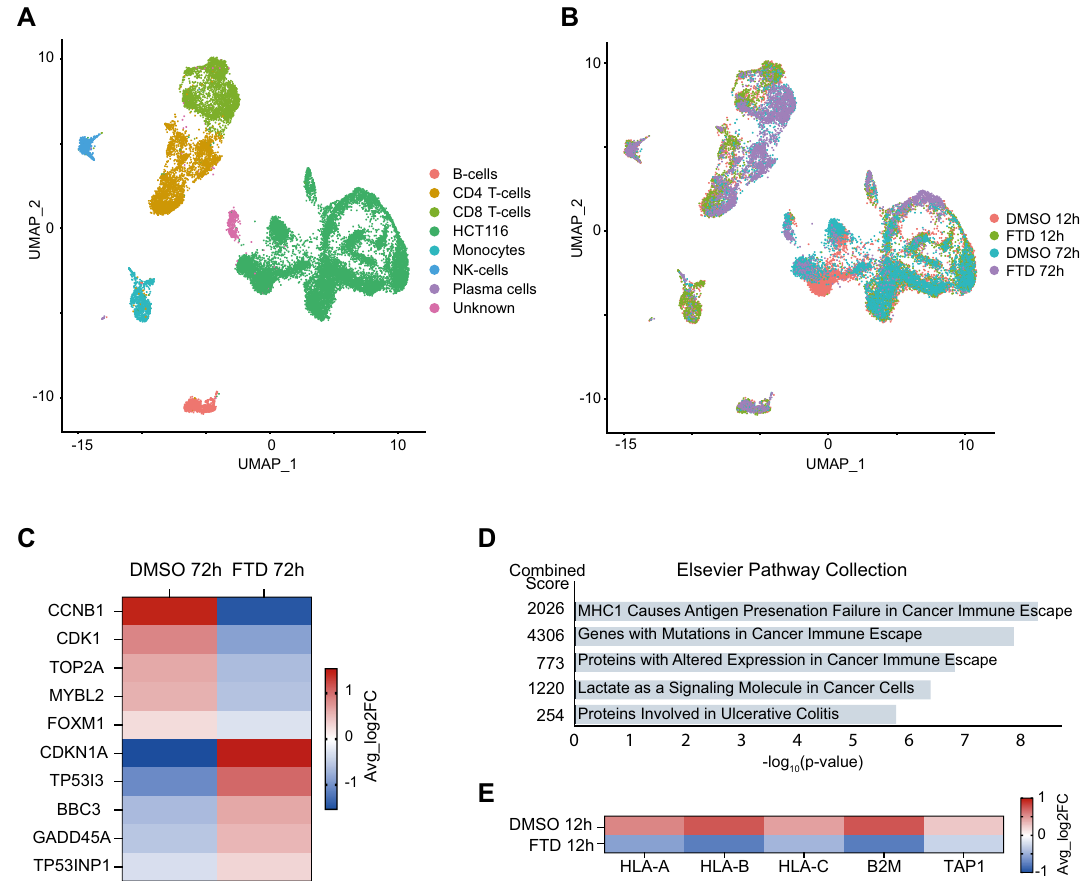
Figure 3. scRNA-seq captures major mechanisms of action of trifluridine. UMAP projection of all cells colored by ( A ) cell type and ( B ) sample identity. ( C ) Heatmap showing average Log2 fold change expression of genes of interest in HCT116 treated with DMSO vehicle (0.1%) or FTD (3 μM) for 72 h. ( D ) Top 5 enriched pathways obtained from pathway enrichment analysis using the “Elsevier Pathway Collection” database. The analysis was performed with 52 DEGs (Adjusted P-value < 0.001) identified for HCT116 treated with FTD for 12 h compared to DMSO vehicle. ( E ) Heatmap showing average Log2 fold change expression of genes of interest in HCT116 treated with FTD for 12 h compared to DMSO